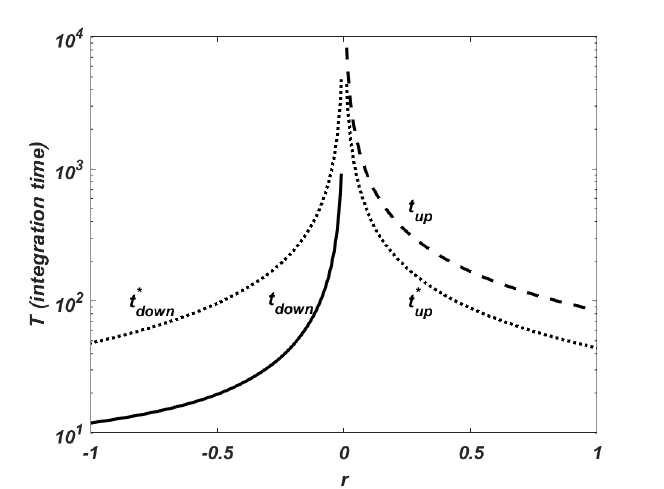
Figure 1. Malthusian growth. Behaviour of the numerical solution depending on r . t down (solid line): time at which the approximated resource shows an exponential decay, its value is lower than 10 − 20 (extinction). t up (dashed line): time at which it shows an exponential growth, its value is higher than 10 20 (unbounded solution). Theoretical values in the absence of the consumer (dotted line): (cid:18) 10 20 (cid:18) 10 − 20 (cid:19) (cid:19) 1 1 = t ∗ up = log log , r > 0, and t ∗ , r < down r r s 0 s 0